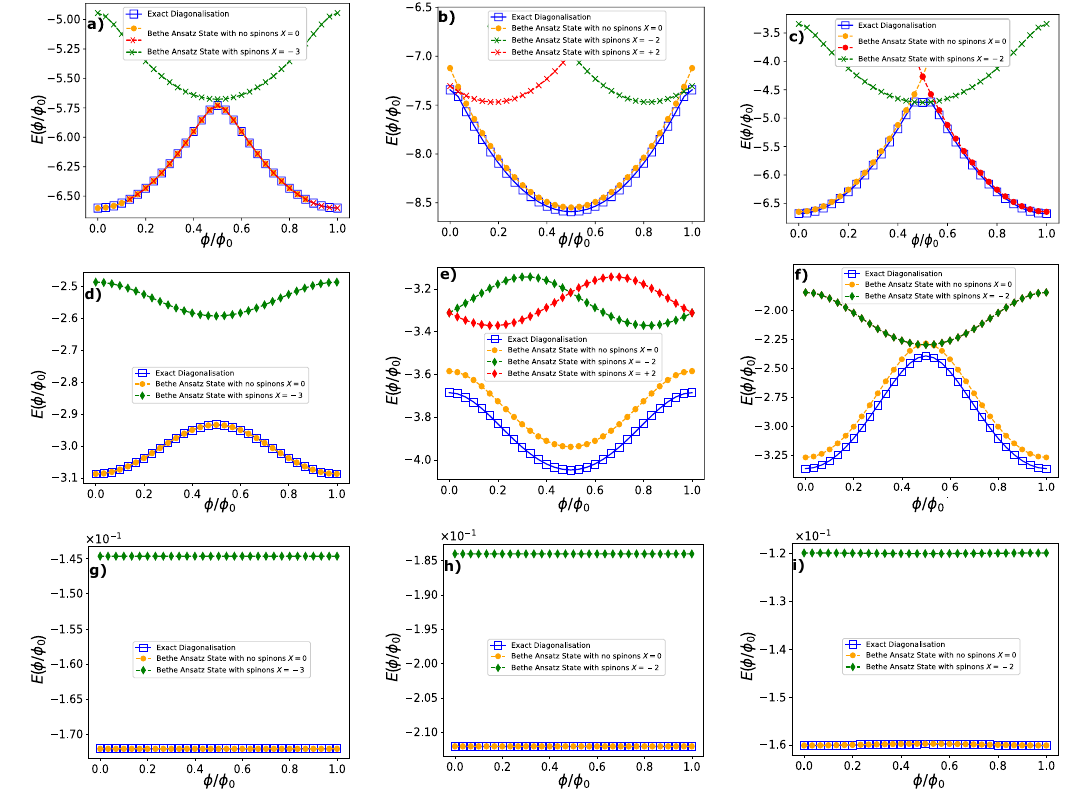
Figure 6: Spinon creation in commensurate SU( N ) fermionic systems. The systems = 6 (left column), SU(3) with N = 6 taken in consideration are SU(2) with N p p = 4 (right column). The different Bethe ansatz (middle column) and SU(4) with N p energies of the Lai-Sutherland model characterized by different spinon configurations needed to make up the ground state of the system are considered for different values of interaction with U = 1 (top row), U = 5 (middle row) and U = 100 (last row). All the presented results are obtained with Bethe ansatz of the Gaudin-Yang-Sutherland = L . The Bethe ansatz states with no spinons, having two different model for N p colours (orange and red), are used to indicate that the I quantum numbers are j shifted due to being in different energy parabolas. In the case of U = 1, the Bethe ansatz did not converge for certain values of the flux. This does not have an impact on what we are trying to discuss here and so they were left